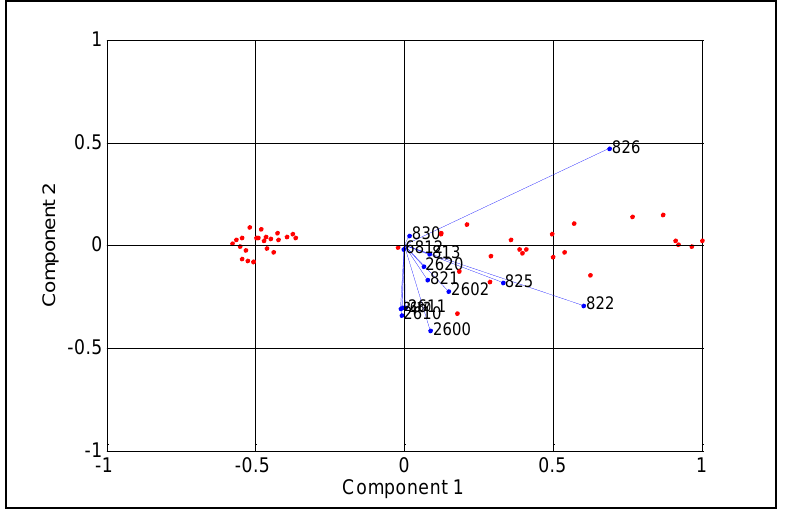
Figure 15. The loading values for analysis on fresh and spoiled